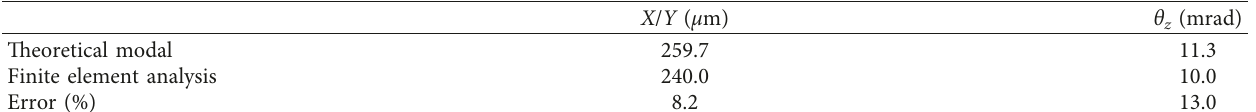
Figure 14: Results of static analysis: (a) motion along the positive X -axis; (b) motion in a direction 45 degrees to the X -axis; (c) motion of rotational part; (d) motion of the entire structure in the θ z direction. Table 3: Comparison of outputs obtained employing the theoretical model and FEA.